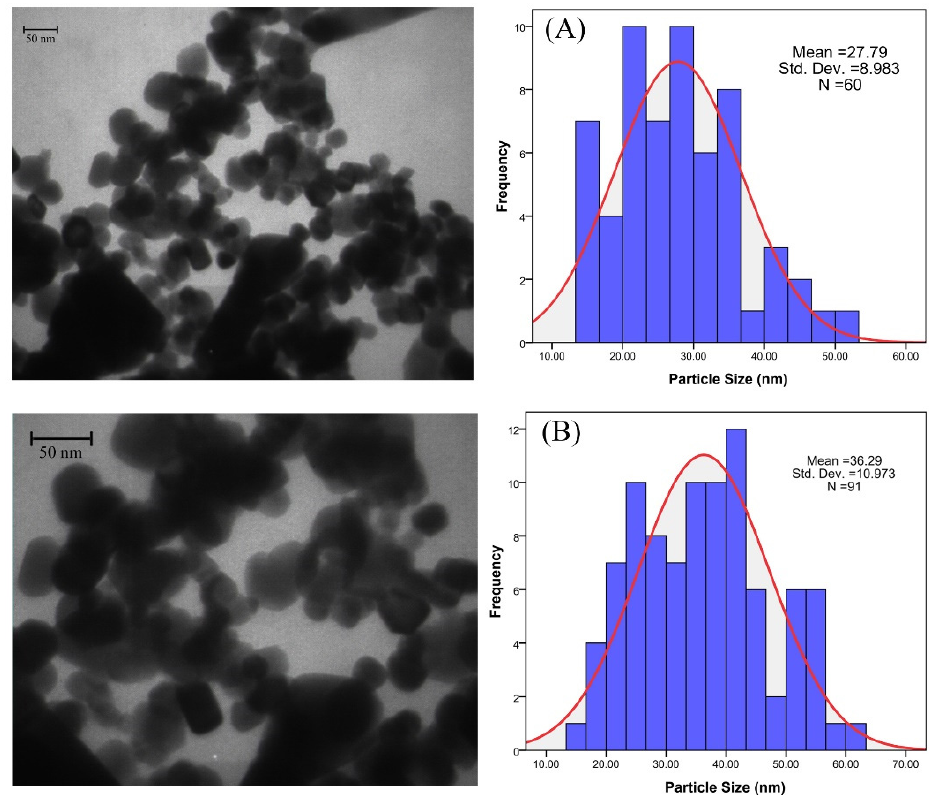
Figure 7. The TEM results of ( A ) the ZnO-NPs. ( B ) Zn 0.97 Ag 0.03 O.